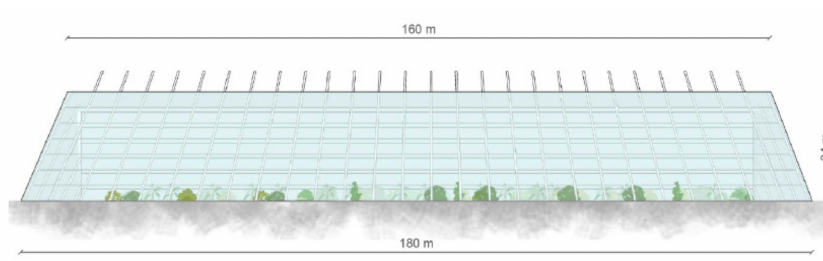
Figure 1. Top view of the building [33].